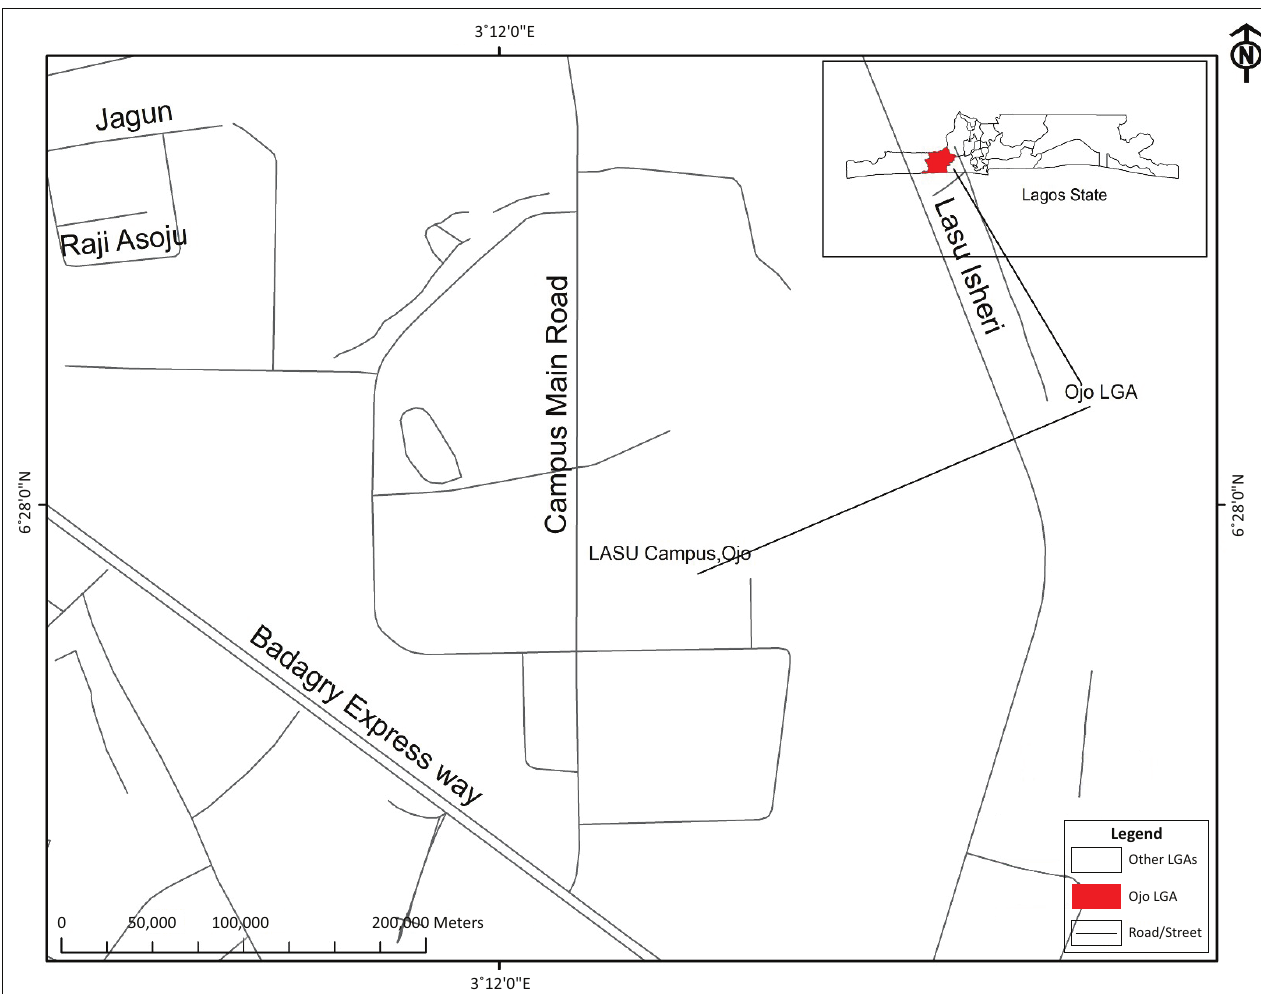
FIGURE 1: Map of Ojo Local Government Area (LGA) of Lagos State showing the location of the study